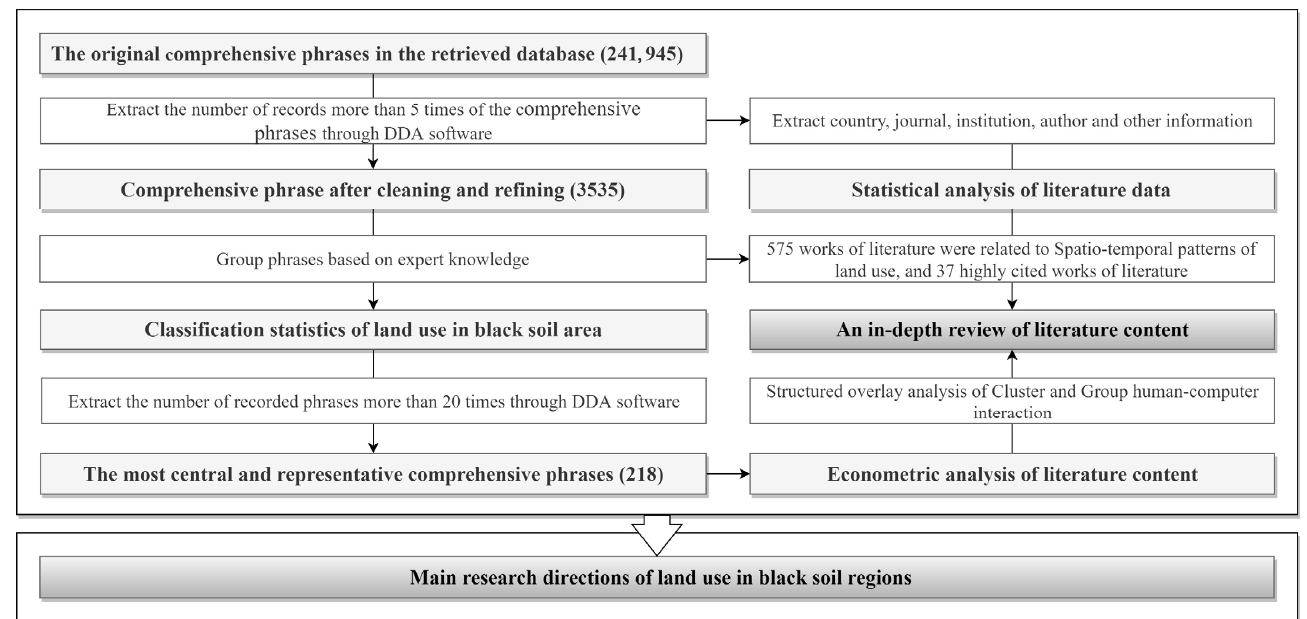
Figure 1. Workflow of the systematic review. The data collection and refinement process is on the left. The process of bibliometric analysis and review is on the right.